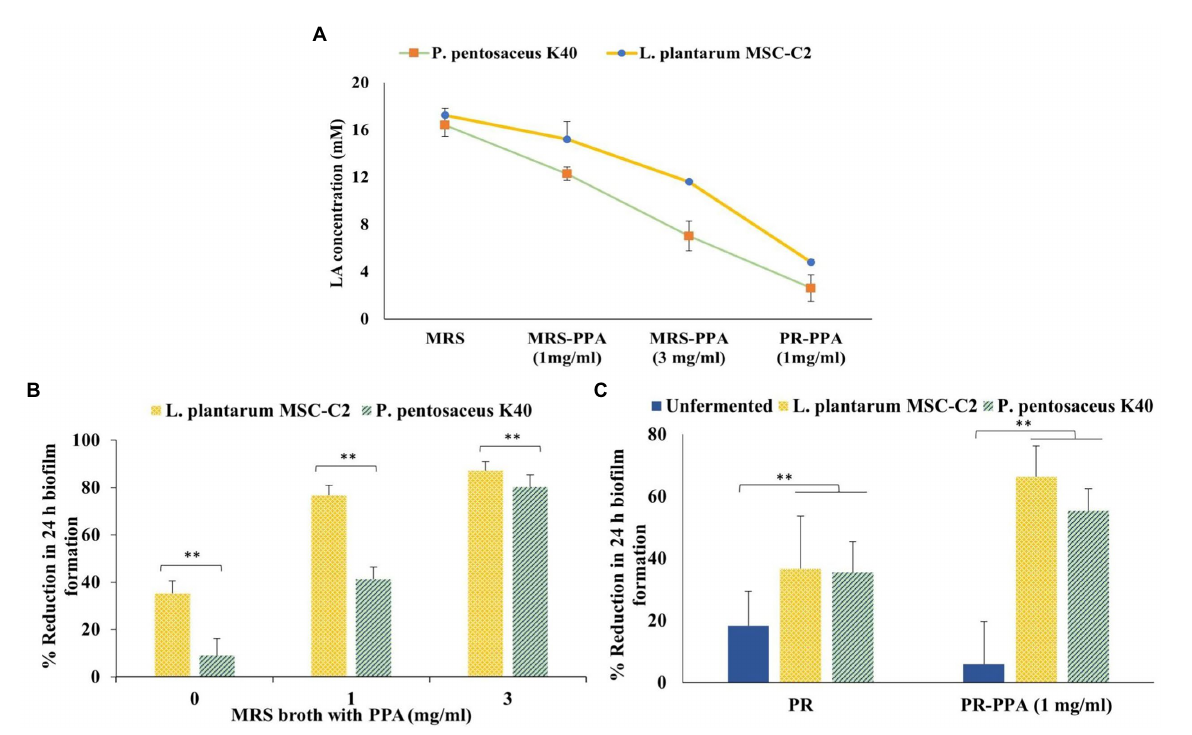
FIGURE 4 (A) Concentration (mM) of LA in PLA-containing LAB extracts from MRS broth, MRS-PPA (1 mg/ml), MRS-PPA (3 mg/ml), and PR-PPA (1 mg/ml). (B) Effect of PLA-containing LAB extracts against 24 h biofilm formation by A. actinomycetemcomitans from MRS broth, MRS-PPA (1 mg/ml), and MRS-PPA (3 mg/ml). (C) Unfermented and LAB-fermented PR extract with or without 1 mg/ml PPA. Data represent the mean value from three independent assays in triplicate, and error bars represent the standard deviation (SD). Differences between groups were determined via one-way ANOVA. ** p < 0.05 between the groups represented in the